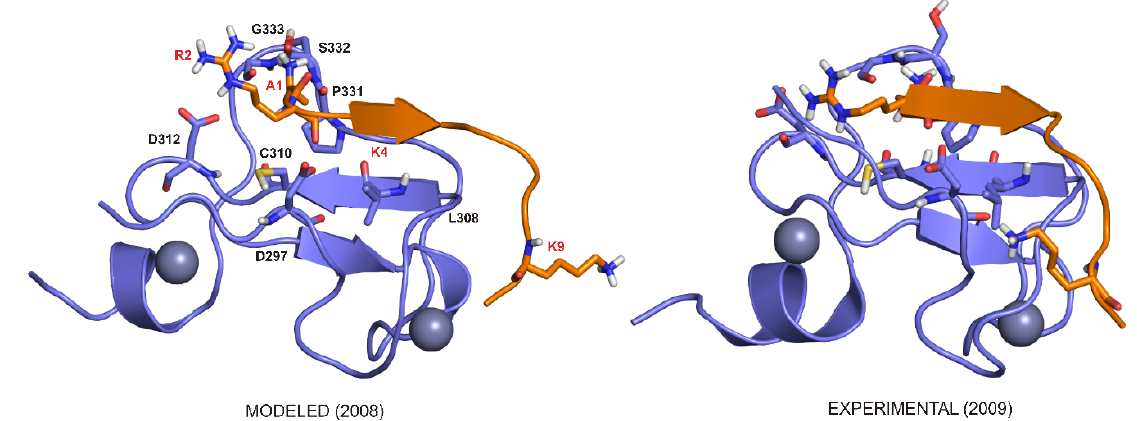
Figure 8. Comparison of modeled [130] and experimental [95] structures of histone H3K4me0 (orange cartoon) in complex with AIRE PHD finger (navy blue cartoon). Zinc ions and key residues are shown as navy blue spheres and labelled sticks, respectively. There is a good agreement between the modeled and the experimental structures both capturing the antiparallel ß-strand as binding conformation of histone H3K4me0.